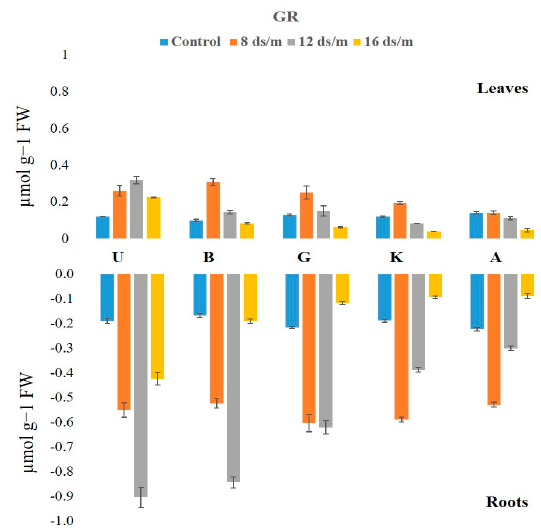
Figure 9. Effect of NaCl-mediated stress on GR activity in root tissues of pistachio.